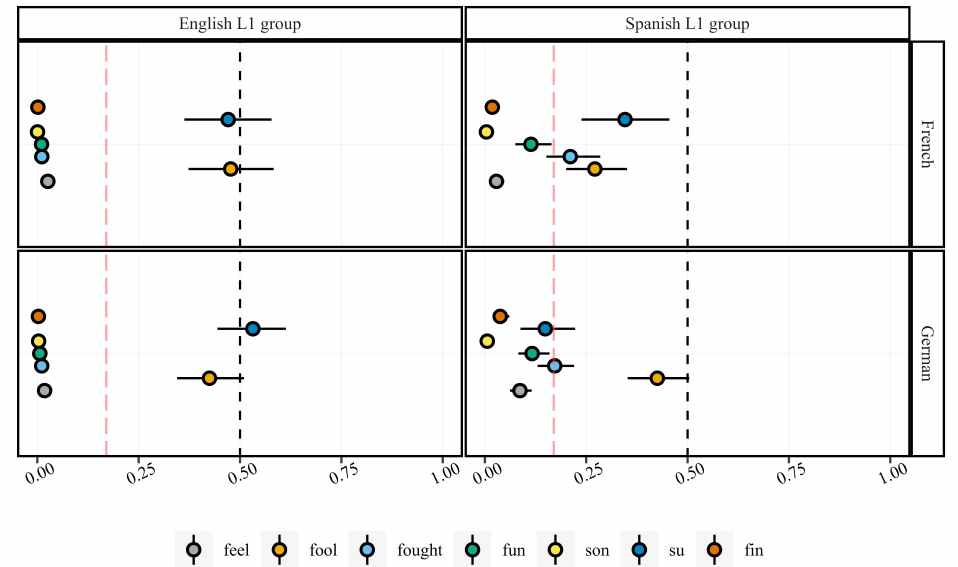
Figure 13. The probability of each answer choice given the phoneme